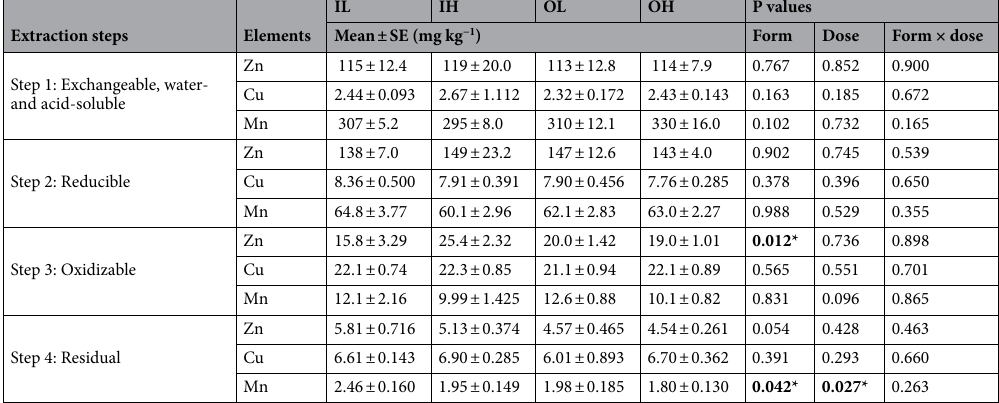
Table 4. Sequential extraction of Zn, Cu and Mn from faecal samples collected on day 14. Significant values are in bold. OH organic minerals offered at higher doses, OL organic minerals offered at lower doses, IH inorganic minerals offered at higher doses, IL inorganic minerals offered at lower doses. The symbol ‘*’ indicate statistical significance of ANOVA test at p-value < 0.05.